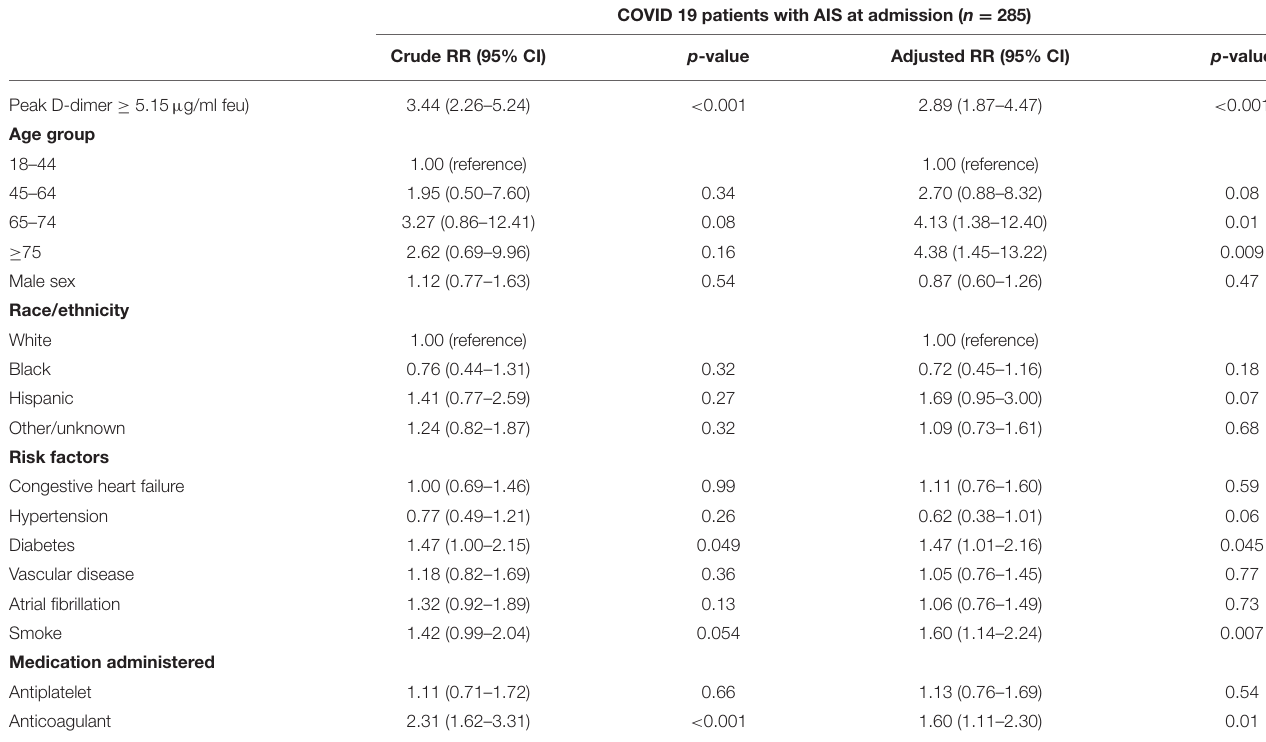
TABLE 2 | Factors associated with mortality among hospitalized COVID-19 patients with acute ischemic stroke. COVID 19 patients with AIS at admission ( n =